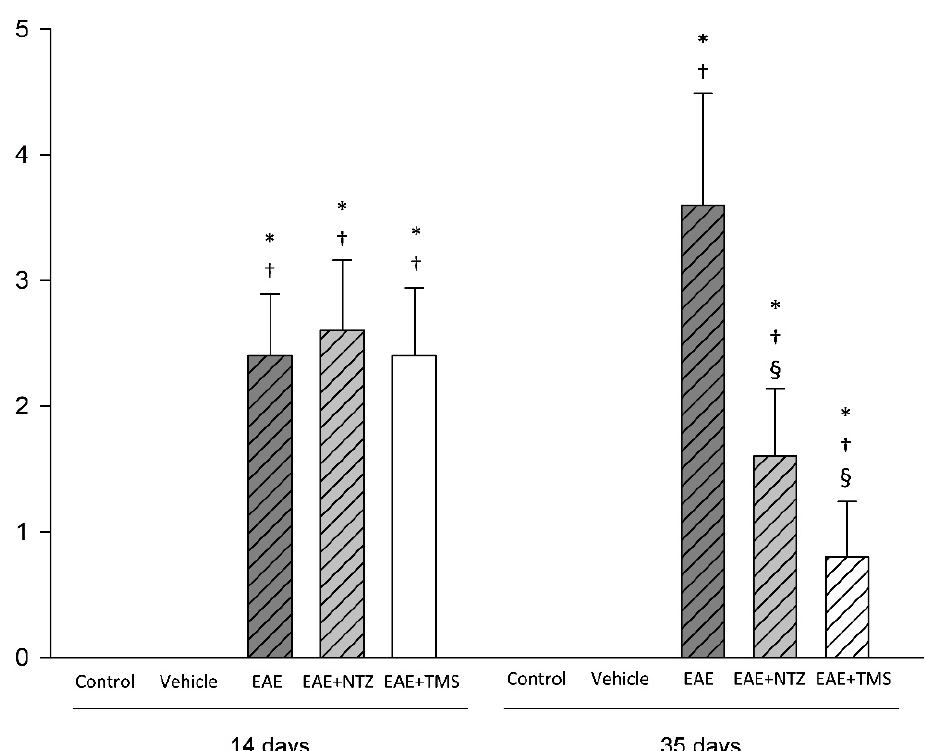
Figure 1. Clinical rating at the beginning (day 14) and at the end of treatments (day 35). All the values are expressed as the mean ± standard deviation (SD). * p < 0.05 versus the control group; † p < 0.05 versus the vehicle group; § p < 0.05 versus the experimental autoimmune encephalomyelitis (EAE) group; # p < 0.05 versus the EAE + NTZ group.